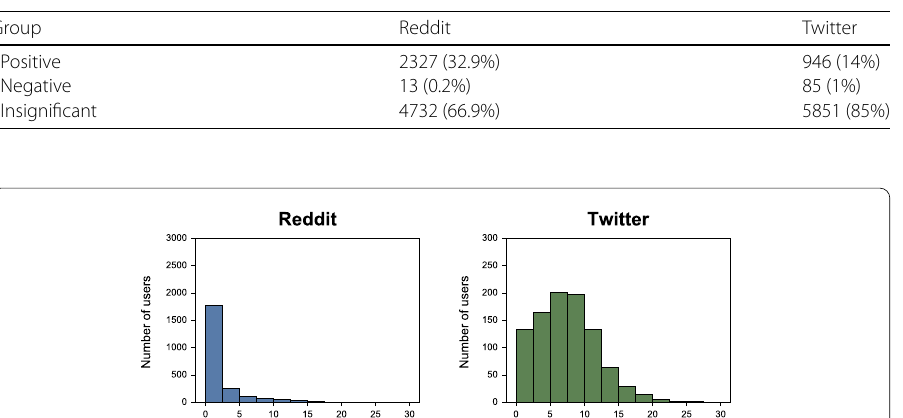
ysis (Sect. 5), the susceptibility of a user is considered to be positive (negative) when the lower (higher) bound of 99% confidence interval of the susceptibility α i is higher (lower) than zero. Table 5 shows the distribution of users with positive and negative susceptibility users (about 67% and 85% in Reddit and Twitter, respectively). Second, there are few